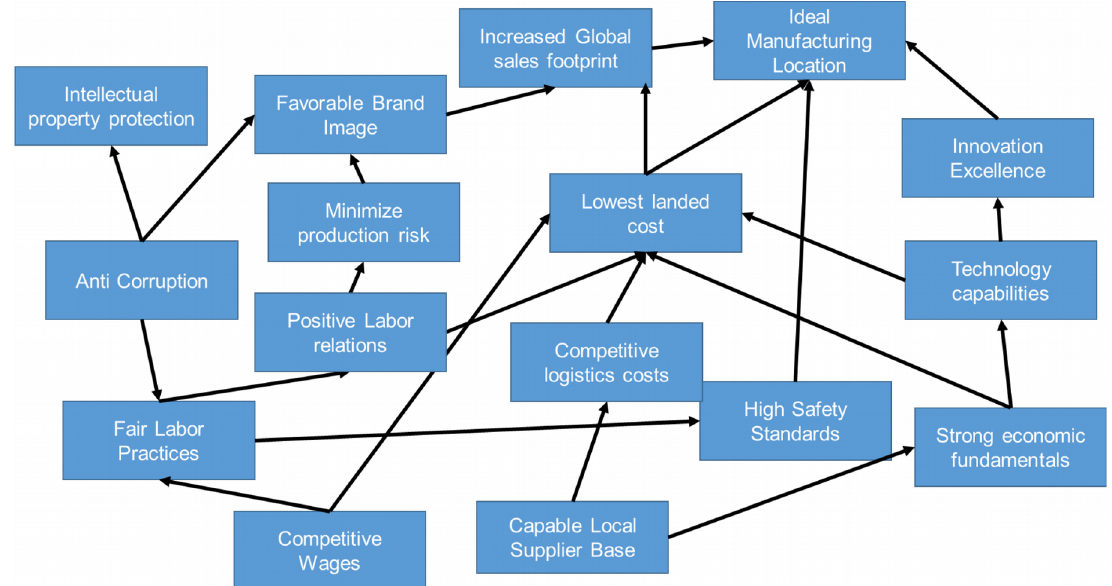
Figure 2. Means objective